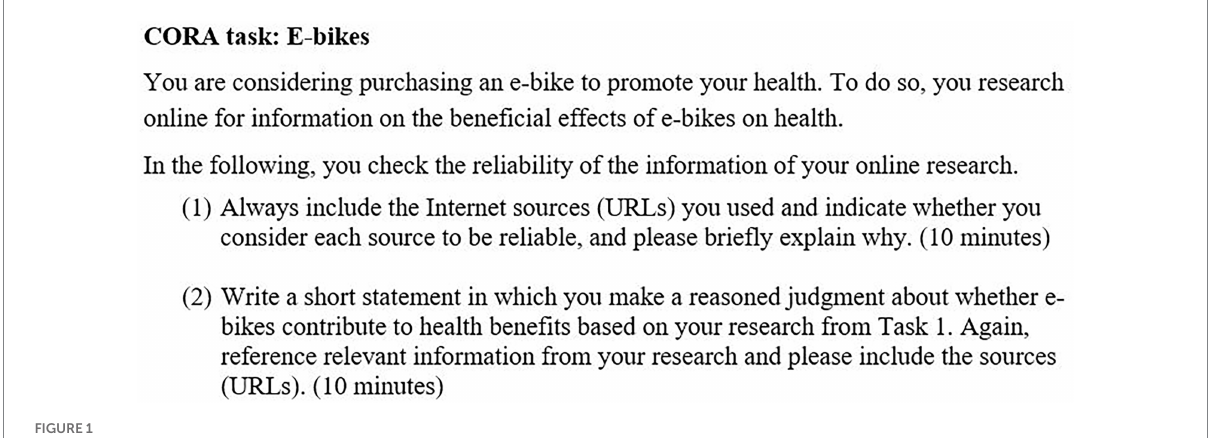
FIGURE 1 Sample task of the Critical Online Reasoning Assessment